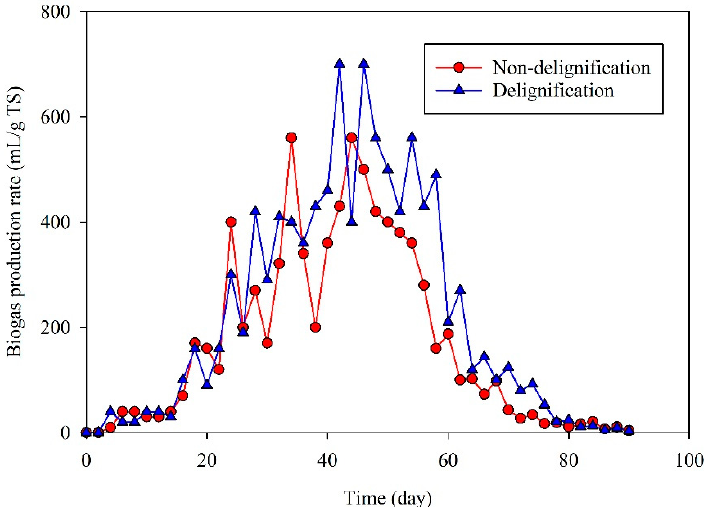
Figure 11. Effect of different pretreatments on the biogas production rate of 20% total solids (TS) C/N 25 (g/g).